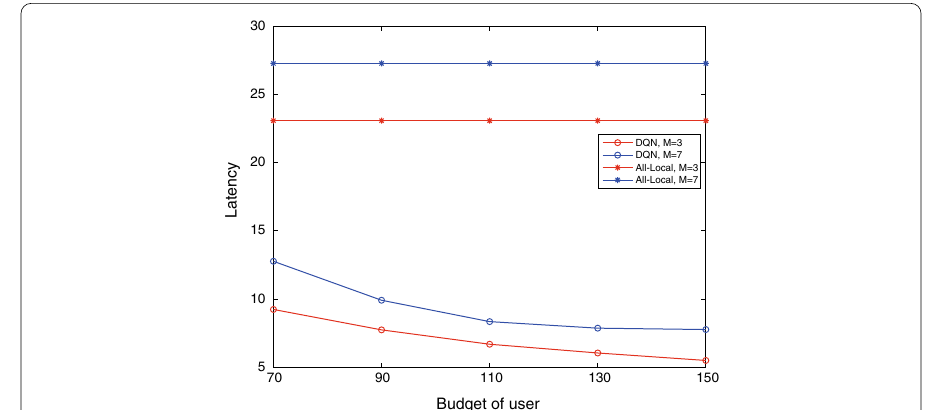
Fig. 7 Effect of budget on the system latency of the proposed scheme with M = 3 and M = 7